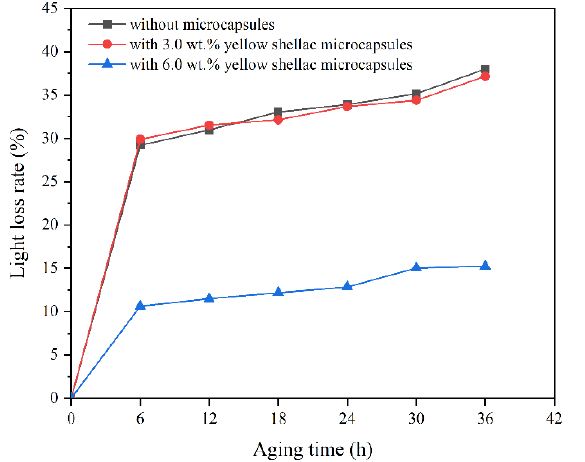
Figure 14. The light loss rate of the coating on Beli wood with yellow shellac microcapsules after aging.